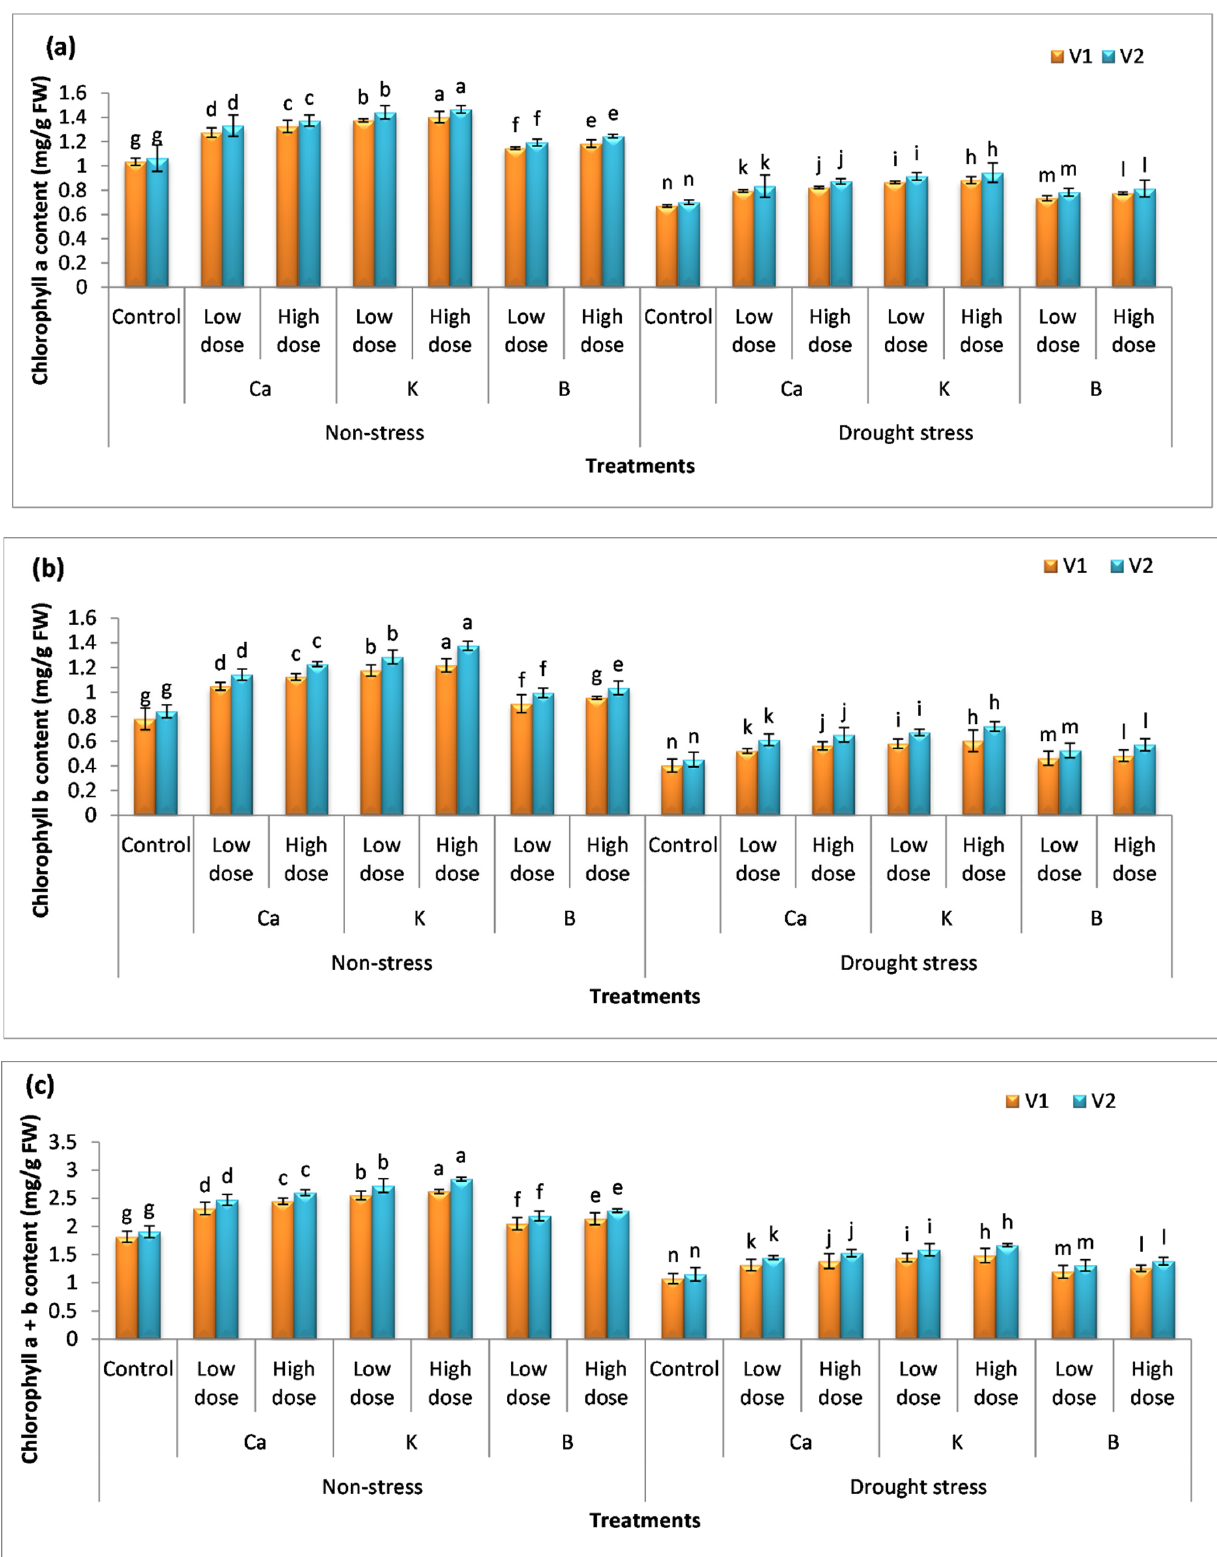
Figure 2. Effect of Ca, K, and B on the physiological attributes of durum wheat. The figure includes ( a ) chlorophyll a content, ( b ) chlorophyll b content, and ( c ) chlorophyll a + b content of durum wheat, where V1 = Preco and V2 = Kronos. The different letter shows significant difference among the mean values of treatments.